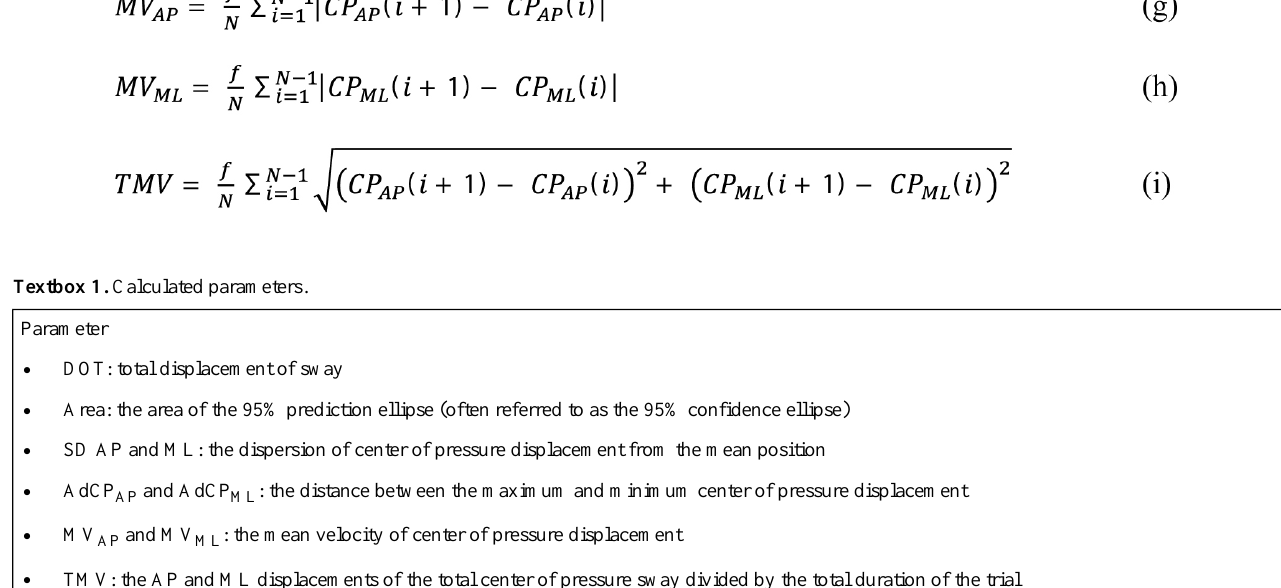
table. Chi-square tests were computed to detect interactions